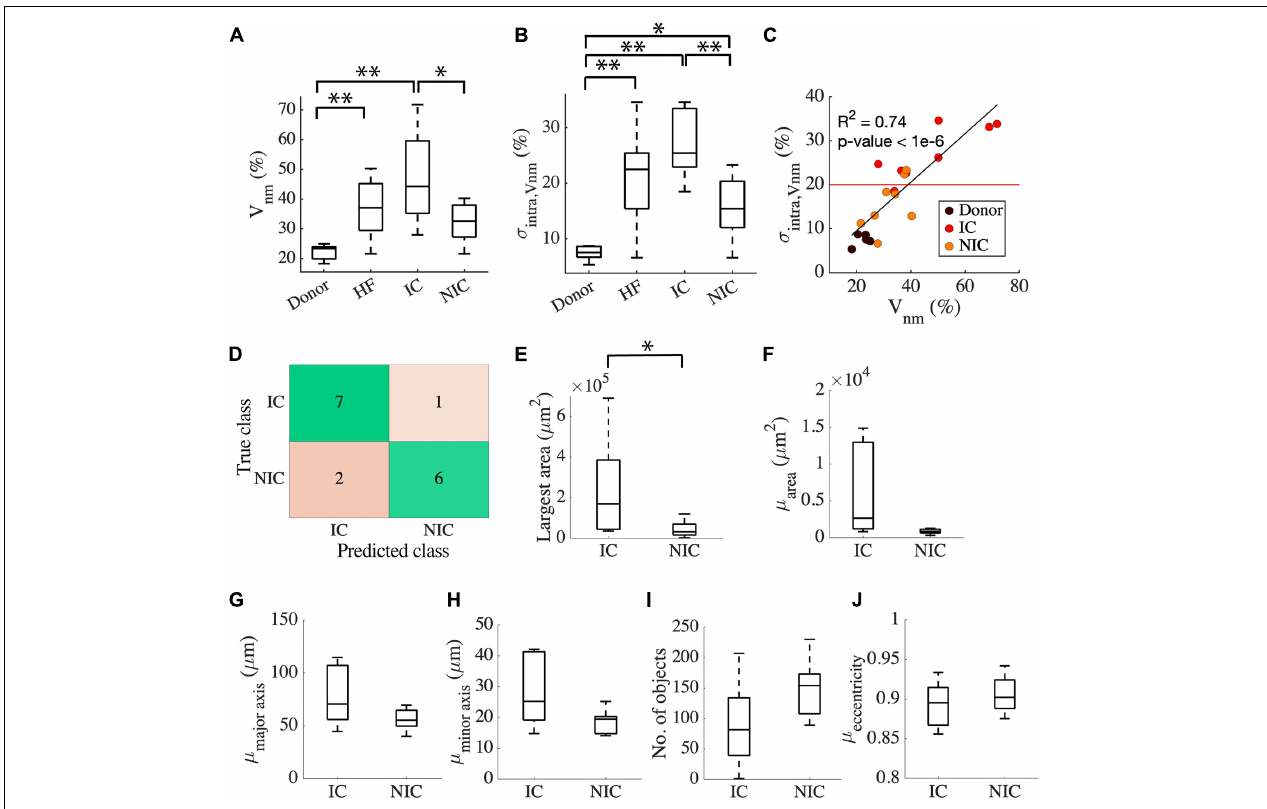
FIGURE 3 | Classification of HF by fibrosis characteristics relates to disease etiology. (A) V nm of the donor has an interquartile range (IQR) of ∼ 5% compared to HF with an IQR of ∼ 30%. HF split to IC ( n = 8), and NIC ( n = 8) revealed an IQR of ∼ 10% for NIC and ∼ 35% for IC. (B) σ intra , Vnm has a median < 10% for donors, > 20% for IC, and ∼ 15% for NIC. (C) Strong relationship between σ intra , Vnm vs. V nm displayed by the linear regression represented by the black line segment. The red line segment shows that σ intra , Vnm = 20.58% discriminated most IC from NIC. (D) Classification of HF by k -means algorithm applied to σ intra , Vnm was 81.25% accurate. Connected component analysis of fibrotic objects in images showed that (E) area of the largest object was larger in IC than NIC. The (F) mean area and the mean lengths of (G) major and (H) minor axes of the patches were not different for IC and NIC. IC and NIC were not differentiated by (I) the number of isolated fibrotic objects with area > 150 µ m 2 or (J) the eccentricity of the patches. * p < 0.05; ** p < 0.01. Outliers in HF are not indicated in panel (A)